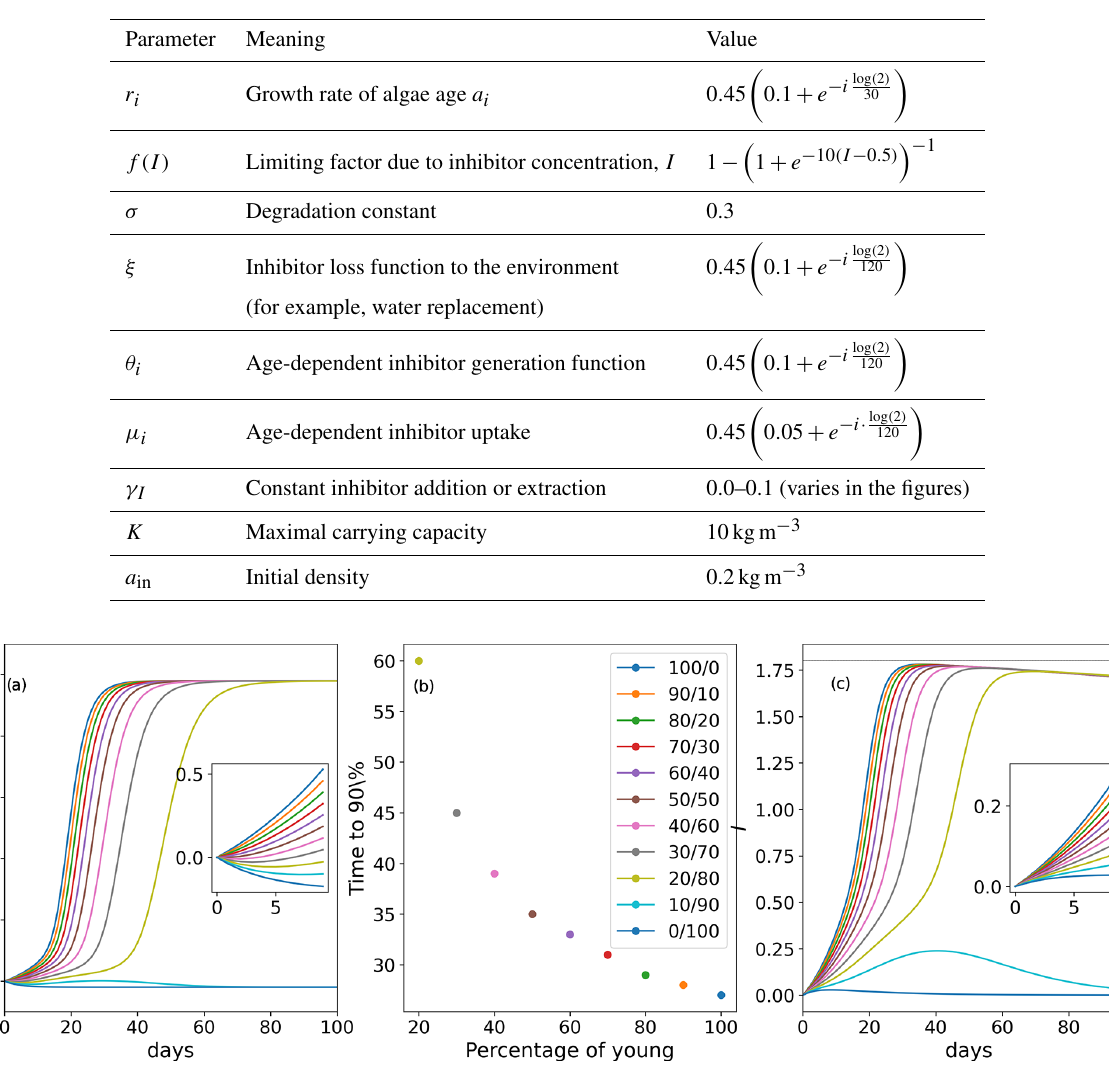
Figure 2. (a) Yield for populations with various initial age mixes (biomass gain in kgm − 3 up to the limit of 10kgm − 3 in a bioreactor with a starting density of 0.2kgm − 3 in total for each simulated age mix (young/old thalli in %)). (b) Ulva biomass growth kinetics as a function of the initial age distribution of thalli in the population. Values of the 0 / 100 and 10 / 90 populations are not presented as they did not reach 90% of the maximal carrying capacity. In any other case, mixed populations achieved at least 90% of the maximal biomass carrying capacity (c) . Inhibitor ( I ) amount in the system over time. Insets in (a) and (c) present zoomed-in dynamics during the first